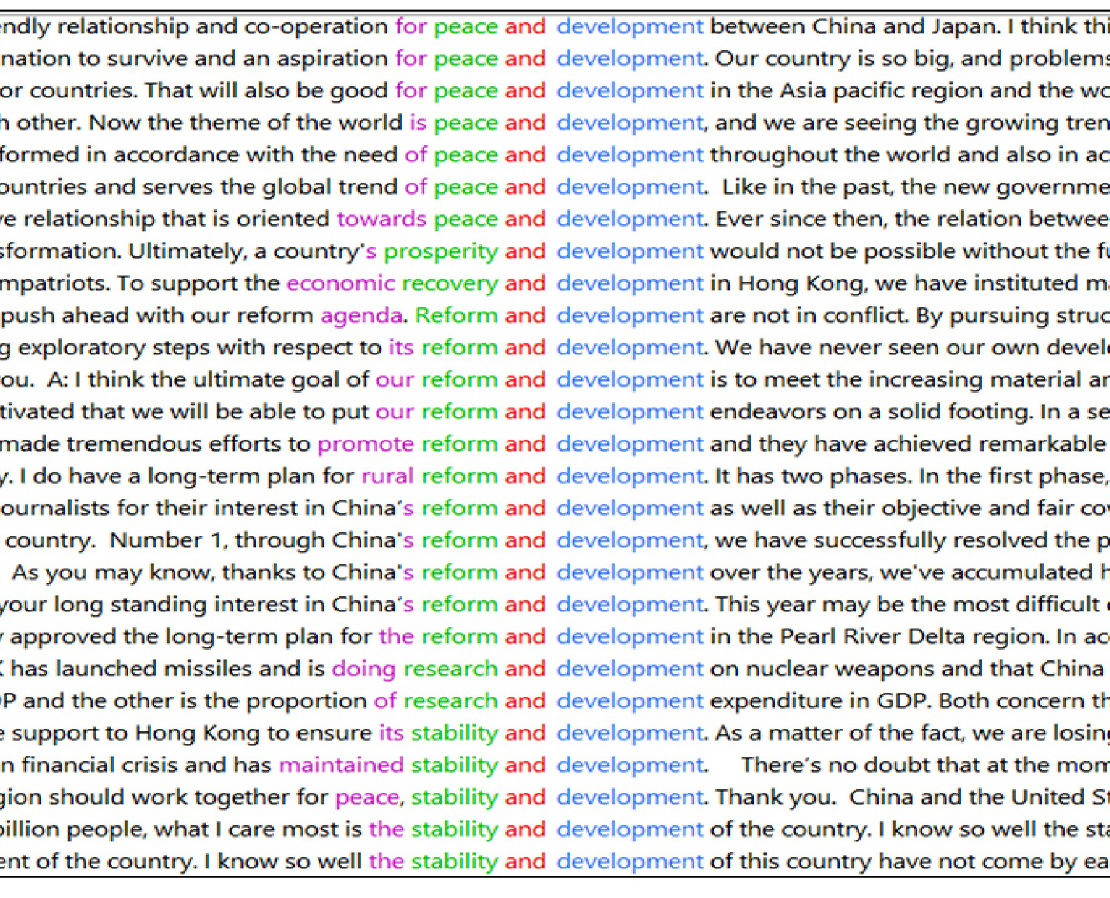
Fig 1. Collocations relating to ‘development’.